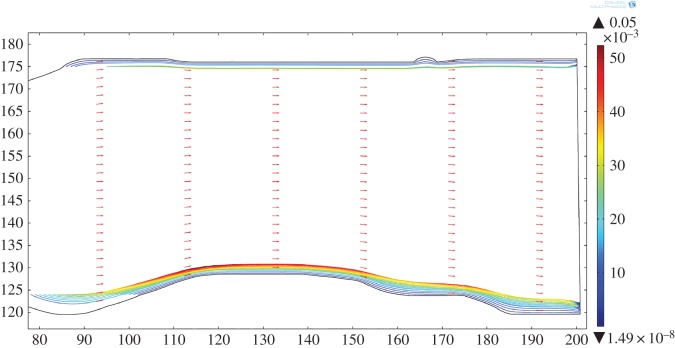
Simulation geometry as in figure 10 but with magma viscosity 103 Pa s. Streamlines show particle trajectories. No eddy formation. Reynolds number ∼ 0.60.